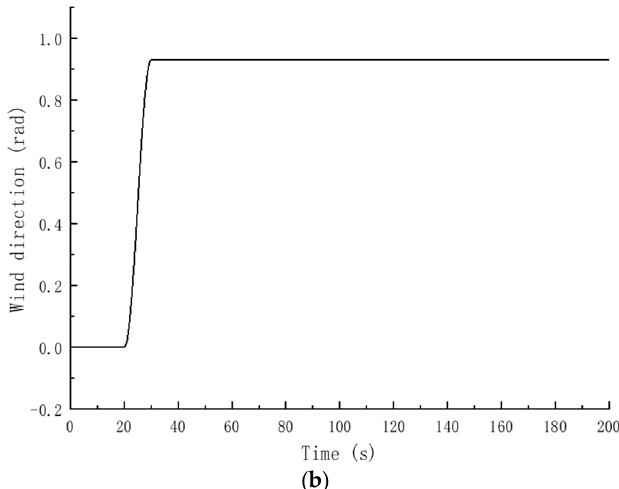
Figure 4. Extreme coherent gust model. ( a ) Wind speed input data. ( b ) Wind direction input data.